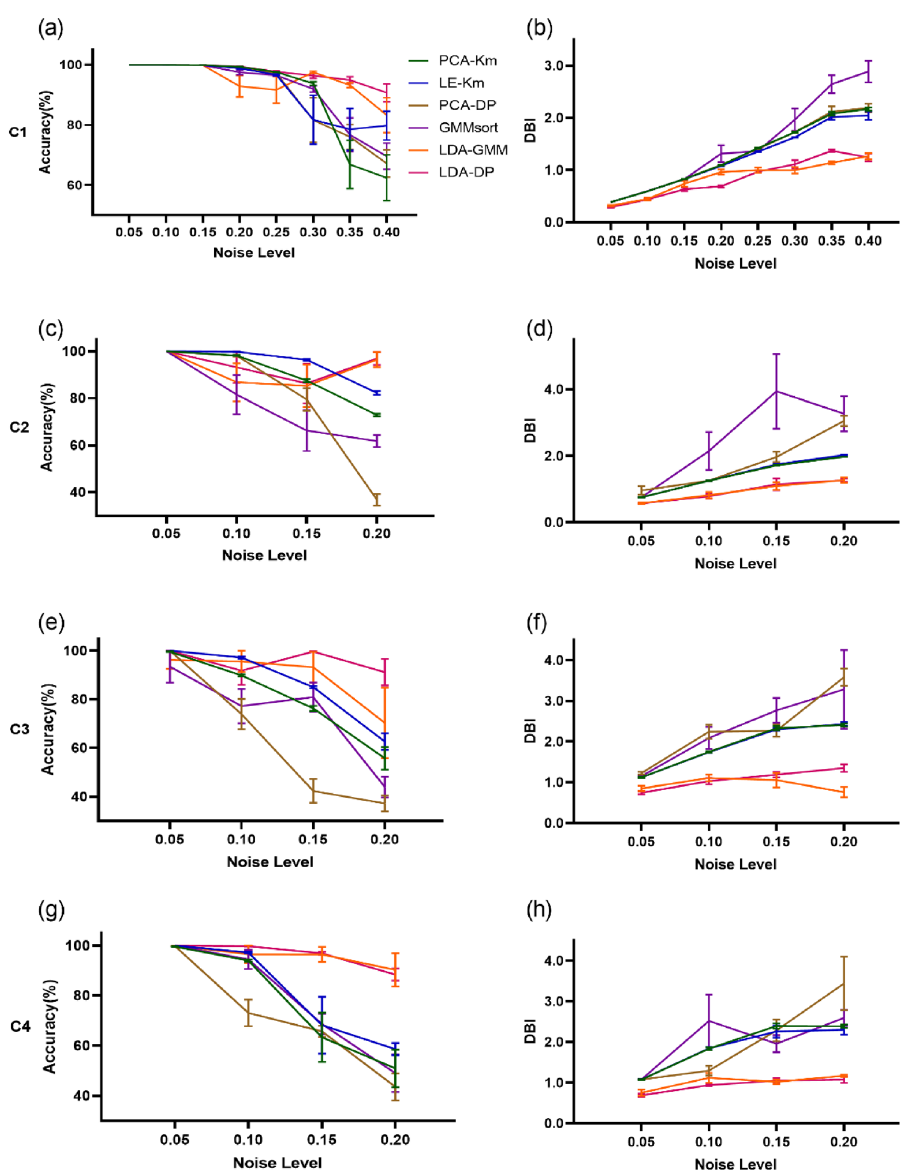
Figure 4. The sorting performance of 6 spike sorting algorithms on Dataset A concerning noise levels. ( a ) We compared sorting accuracy of PCA-Km, LE-Km, PCA-DP, LDA-GMM, GMMsort and LDA-DP with respect to noise on the testing set C1 (noise level: 0.05, 0.1, 0.15, 0.2, 0.25, 0.3, 0.35, 0.4). Error bars represent s.e.m.. ( b ) DBI comparison concerning noise on the testing set C1. The evaluation was performed as in a. ( c – h ) Sorting accuracy and DBI concerning noise on the testing set C2, C3 and C4